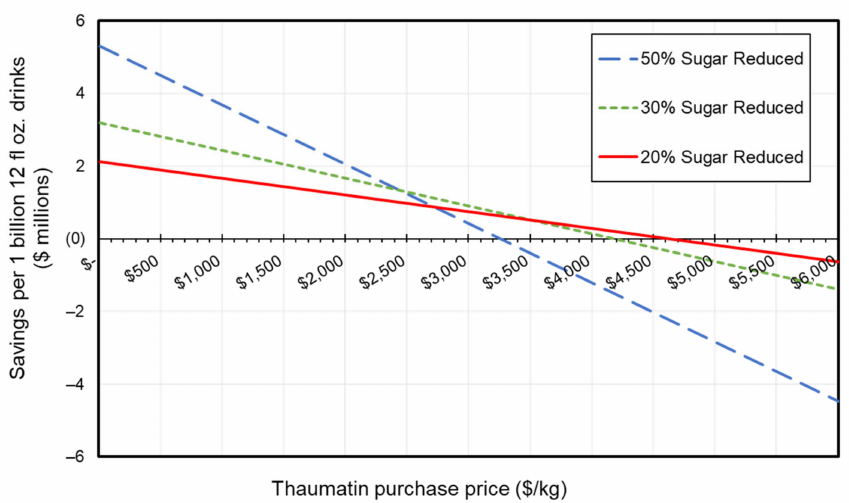
Figure 6. Potential cost savings from thaumatin II use as a function of its purchase price. Tested scenarios of 20%, 30%, and 50% sugar reduction in 10% ( w/v ) sugar sweetened soft drinks assuming a $0.30/kg price of sugar. Thaumatin replacement quantities calculated using a published sensory regression analysis (FDA GRAS GRN